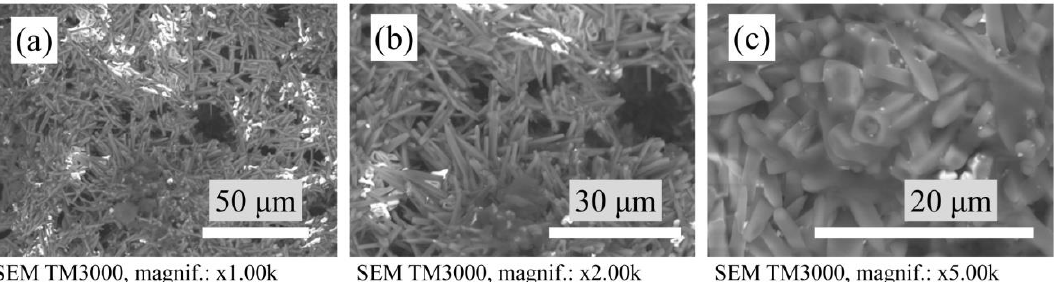
Figure 6. SEM micrographs of the microstructure of sintered samples with MSZ:WO 3 (1:2): ( a ) magnification ×1.00k, ( b ) magnification ×2.00k and ( c ) magnification ×5.00k.